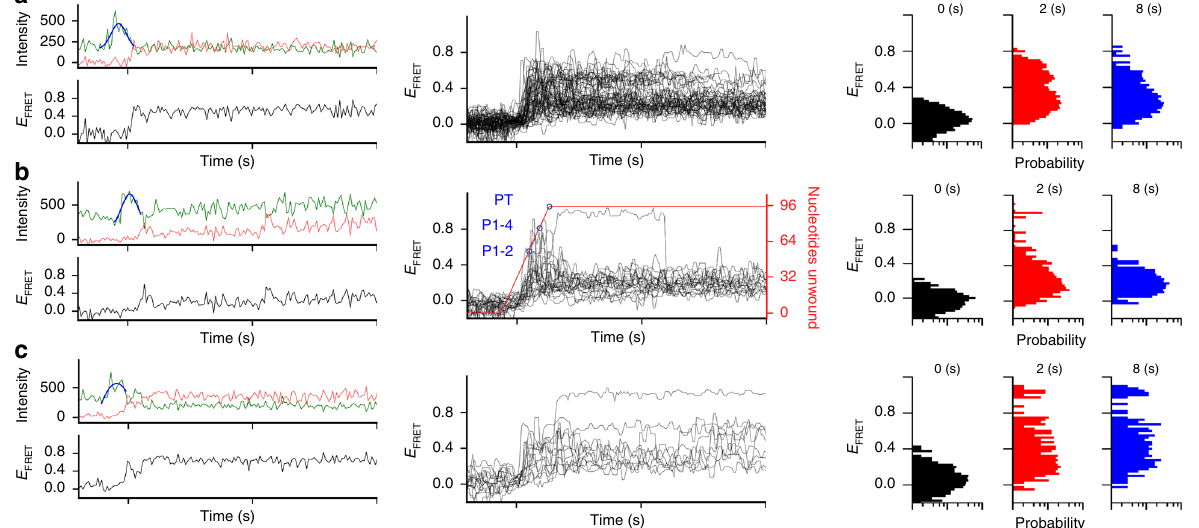
Fig. 6 Real-time observation of heteroduplex unwinding and riboswitch folding in VF assays. a Individual real-time trajectory (left), overlay of all WT ZTP riboswitch folding trajectories (center, n = 56), and histograms of all trajectories at 0, 2, and 8 s after PIFE (right) using VF with Rep-X in the presence of 1 mM ZMP. The PIFE peaks were fi t to a Gaussian (blue) to determine their centers for synchronizing trajectories. b Individual real-time trajectory (left), overlay of all WT ZTP riboswitch trajectories (center, n = 24), and histograms of all trajectories at 0, 2, and 8 s after PIFE (right) using VF with Rep-X in the absence of ZMP. The relative unwinding position is indicated by a red line, based on the experimentally determined Rep-X unwinding rate and the location of U32 on the template. Blue circles indicate time points corresponding to the unwinding and release of helices P1 and P2, helices P1-P4, and terminator helix PT. c Real-time trajectories of terminator mutant 81-83 A in the absence of ZMP using VF with Rep-X, showing an individual trajectory (left), all trajectories overlaid (center, n = 15), and histograms of all trajectories at 0, 2, and 8 s after PIFE (right). The time duration between ticks is 5 s. Histogram probabilities are on a log scale, with ticks of 0.1, 1, and 10